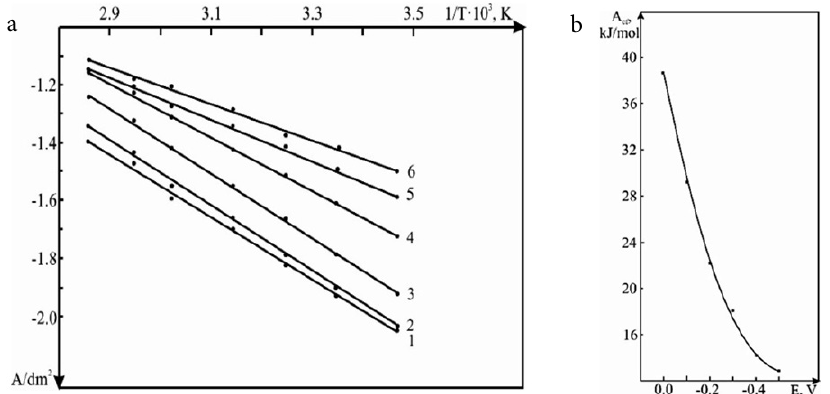
Fig. 3. (a) lgi k – 1/T dependence, at different E(V) = 1- 0.0; 2- (–0.1); 3- (–0.2); 4- (–0.3); 5- (–0.4); 6- (–0.5). (b) Dependence of the activation ener- gy upon the electrode